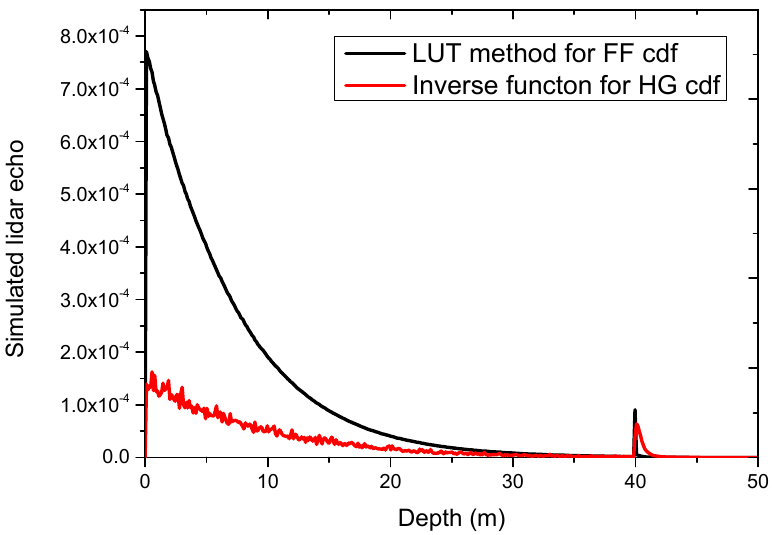
Figure 4. Simulation comparison between inverse equation for Henyey-Greenstein (HG) cumulative distribution function (cdf) and lookup table (LUT) method for Fournier-Forand (FF) cdf. The black curve is based on the LUT method for FF cdf, and the red curve is based on the inverse function for HG cdf. Table 2. The statistics of the curves in Figure 1 by the two methods.